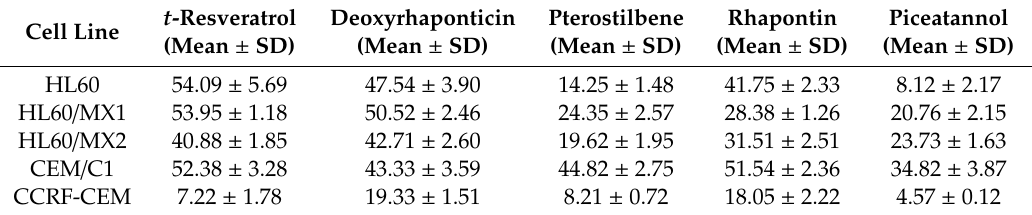
Table 1. IC 50 determined on tested cell lines. Each dose is shown in micromolar concentration [ µ M] as Mean ±